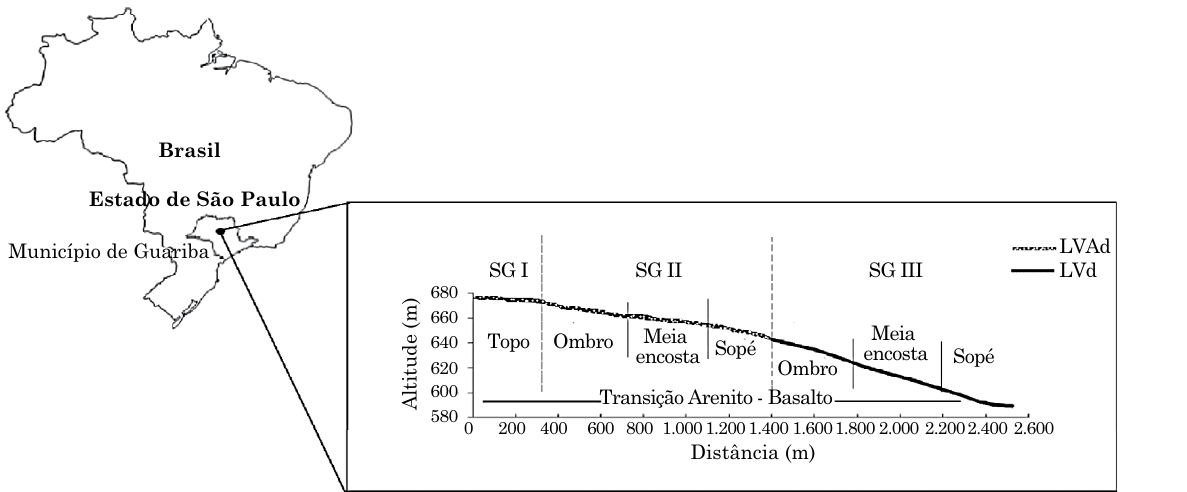
Figura 1. Localização da área e perfil altimétrico com a identificação das superfícies geomórficas (SG), segmentos de vertentes e solos (Latossolo Vermelho-Amarelo distrófico típico textura média = LVAd; e Latossolo Vermelho distrófico típico textura média =